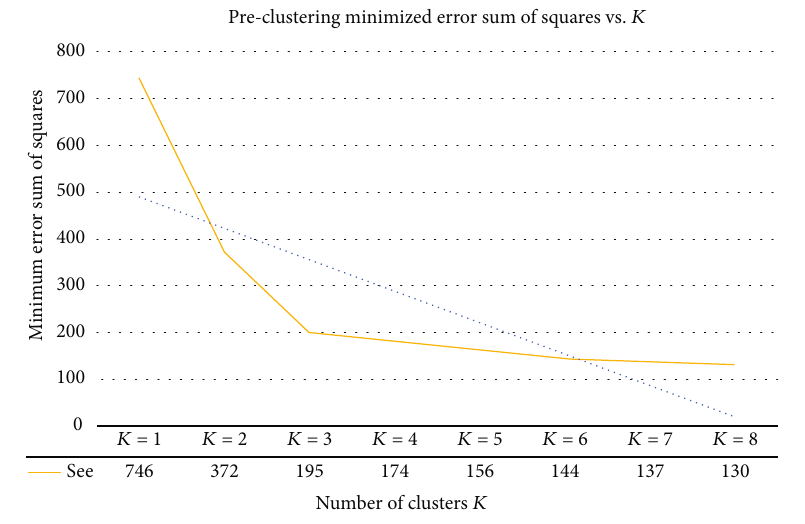
Figure 5: Minimum squared error, the relationship between the sum and the number of clusters K.